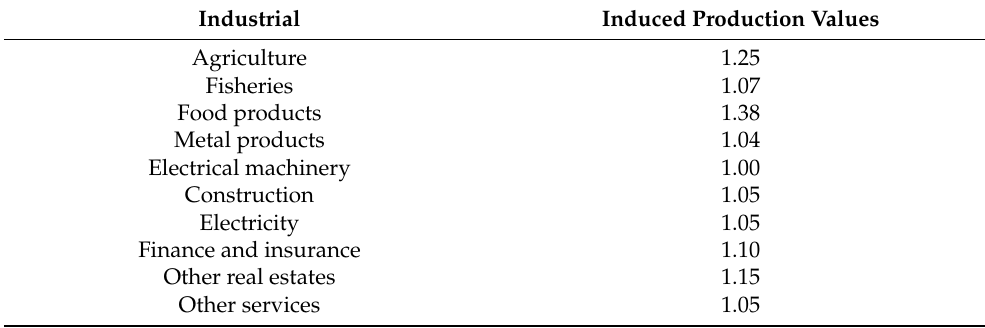
Table 7. Induced production values of Ine town.